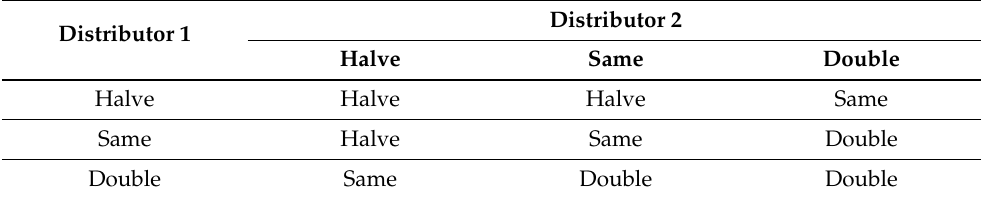
Table 1. The joint action of two